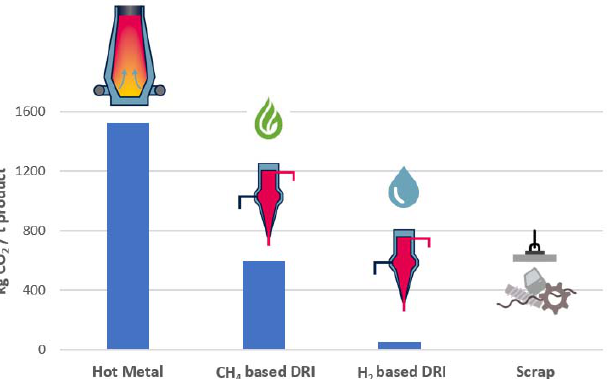
Figure 1. Scope 1 and scope 2 carbon dioxide emission per ton of output product (e.g. per ton of hot